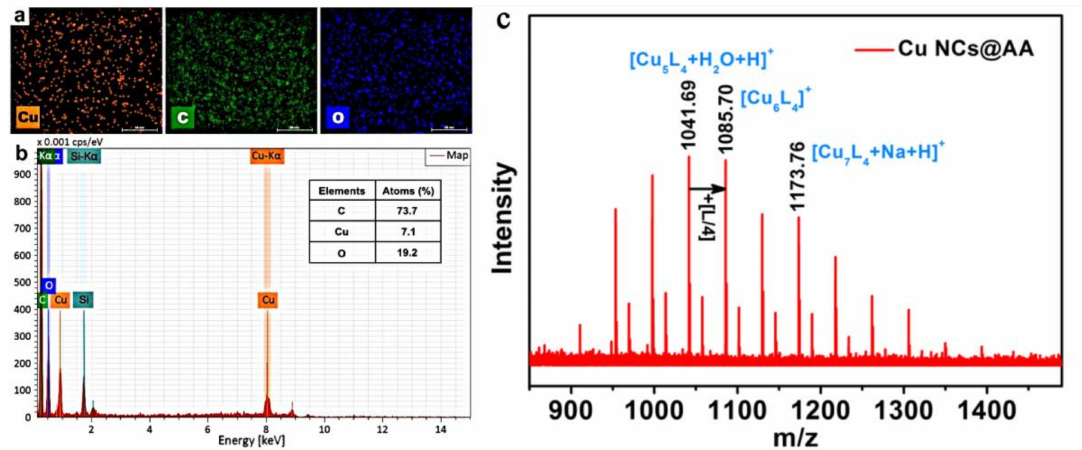
Figure 5. ( a ) Elemental mapping results of Cu, C, and O distribution for Cu NCs@AA. Scale bar: 60 nm. ( b ) The energy dispersive spectrum (EDS) of Cu NCs@AA. ( c ) Positive ion MALDI-TOF MS of